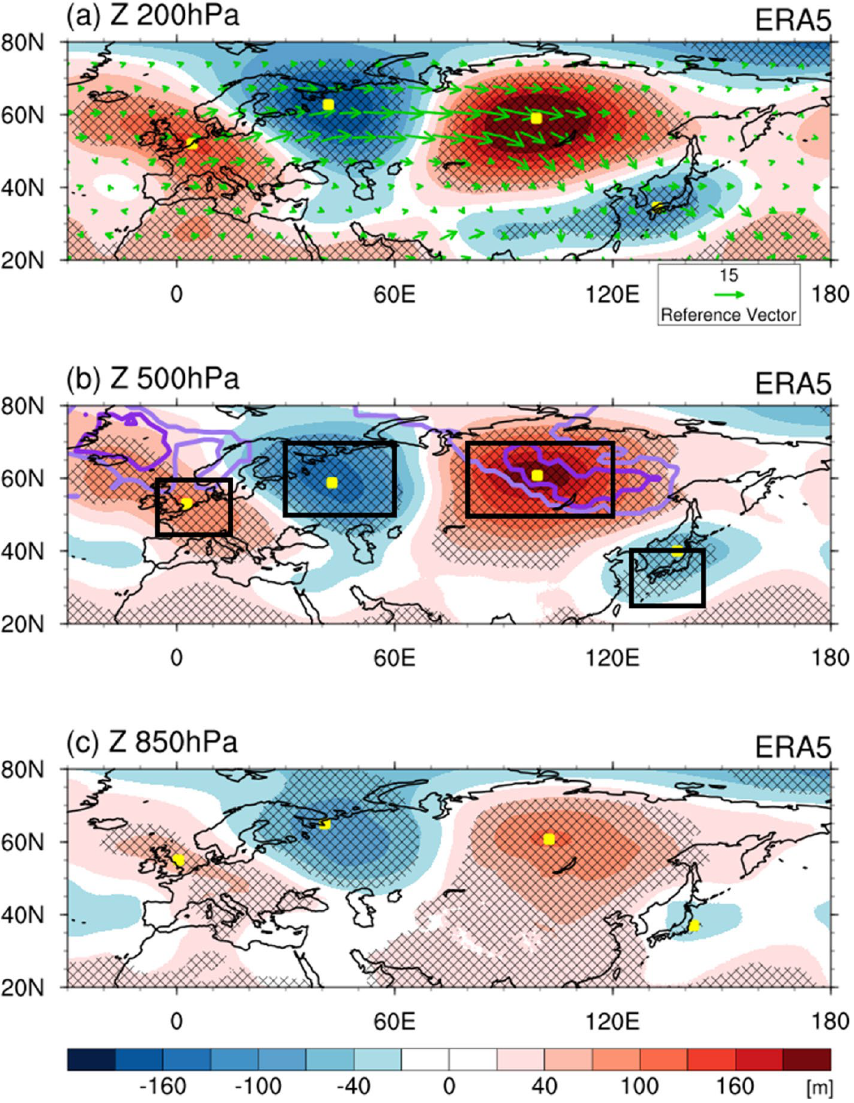
Figure 2. Characteristics of atmospheric circulation anomalies in April 2020. Spatial maps of the ( a ) 200 hPa, ( b ) 500 hPa, and ( c ) 850 hPa geopotential height (shading, m), 200 hPa wave activity flux (vector, m 2 s −2 ), and blocking frequency (contour, days per month) anomalies in April 2020 for ERA5. Yellow squares indicate the location where the maximum or minimum geopotential height anomalies. Hatched areas denote the statistically significant regions at the 90% confidence level. In ( a ), the reference wave activity flux vector is 15 m 2 s −2 . In ( b ), the light and dark purple contours indicate the area with blocking days of more than 10- and 15-days per month in April 2020 compared with the climatological average. Black boxes in ( b ) represent the regional domains information for the three indices from left to right: Western/Central Europe (45–60°N, 5°W–15°E), northwestern/central Russia (50–70°N, 30–60°E), Siberia (50–70°N, 80–120°E), and the East Sea (25–40°N, 125–145°E). Maps were created using the NCAR Command Language Version 6.4.0 (http:// www. ncl. ucar.